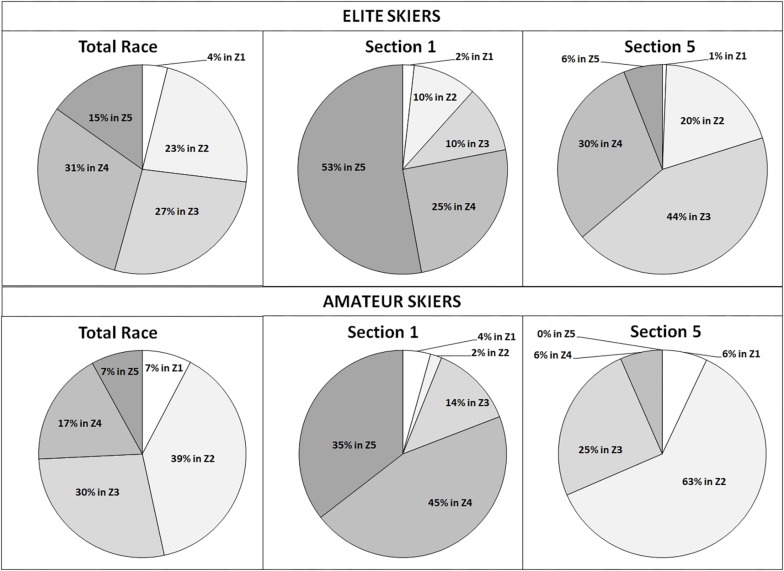
Percent distribution of exercise intensity within the five intensity zones (zone 1, 55–72%; zone 2, 72–82%; zone 3, 82–87%; zone 4, 87–92%; and zone 5, 92–100% of HRmax) for elite skiers and amateur skiers over the total 90-km race, the first section (section 1, 0–11 km) and last section (section 5, 81–90 km).